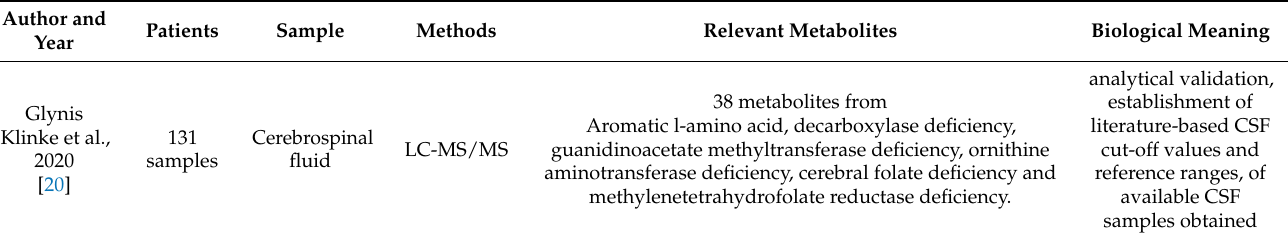
Table 1. Relevant targeted metabolomics studies with cerebrospinal fluid